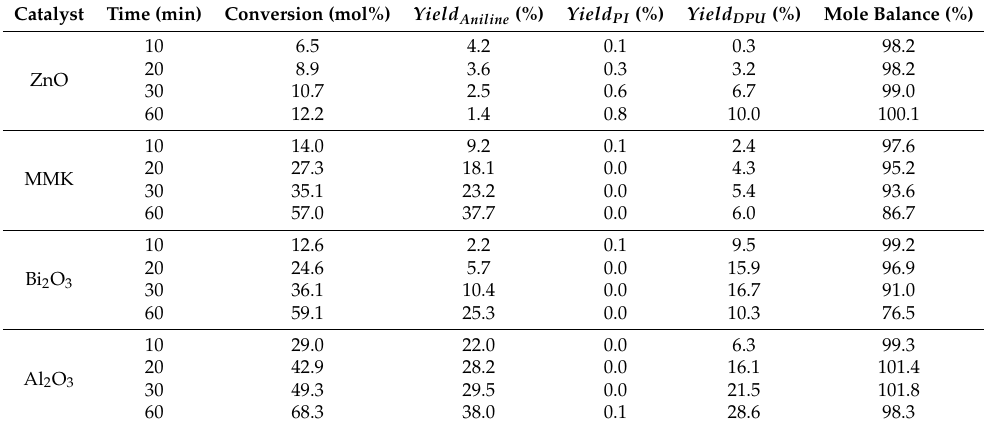
Table 1. Conversion, products yield, and mole balances obtained in the catalytic degradation of MPC (Conditions: 200 °C and catalyst: MPC = 6:10).